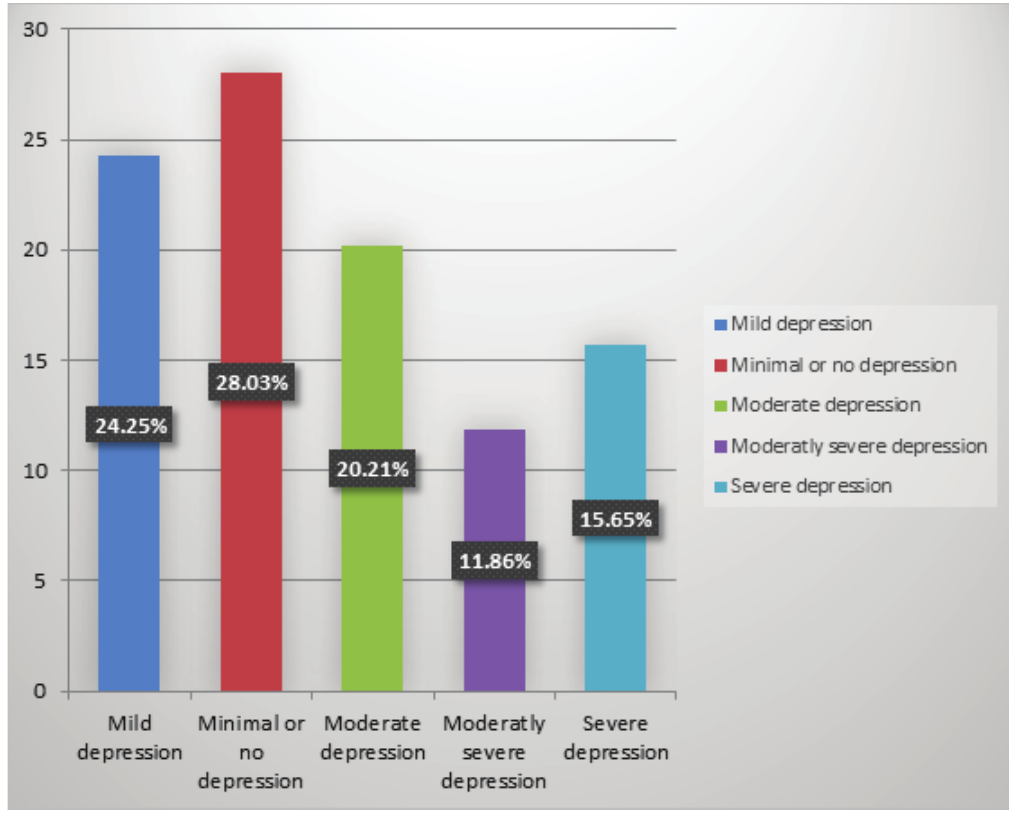
Figure 1: PHQ-9 depression score among